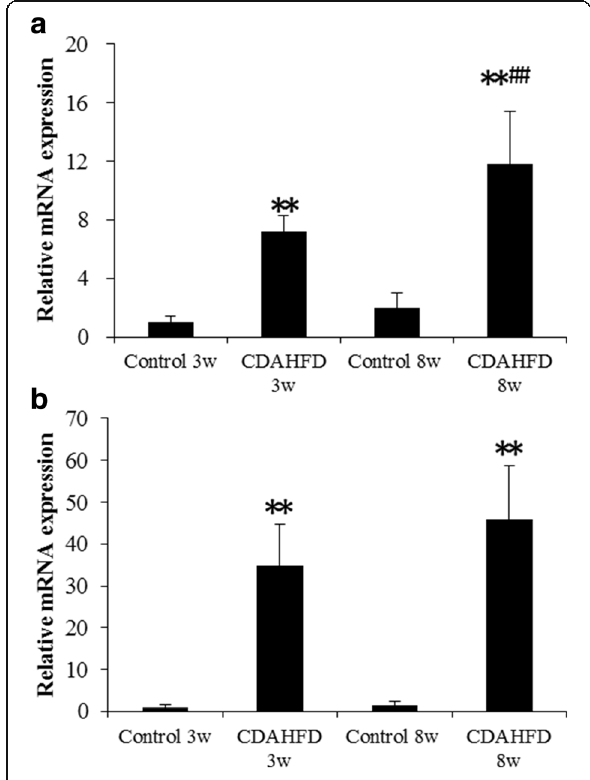
Fig. 7 Hepatic mRNA levels of a α -smooth muscle actin ( α -SMA) and b collagen type 1a1 (Col1a1) in the livers of mice fed a control or choline-deficient, L -amino acid-defined, high-fat diet (CDAHFD). Data are expressed as the mean ± SD ( n = 8 mice per group).